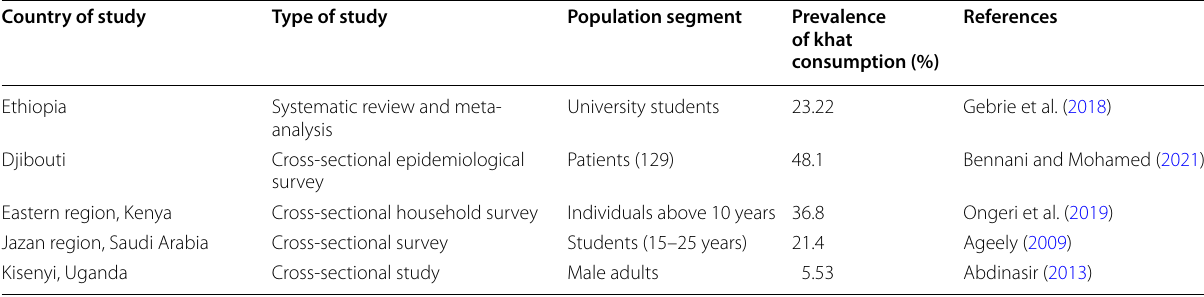
Table 1 Some data on the prevalence of khat consumption in different countries where khat is prevalent Country of